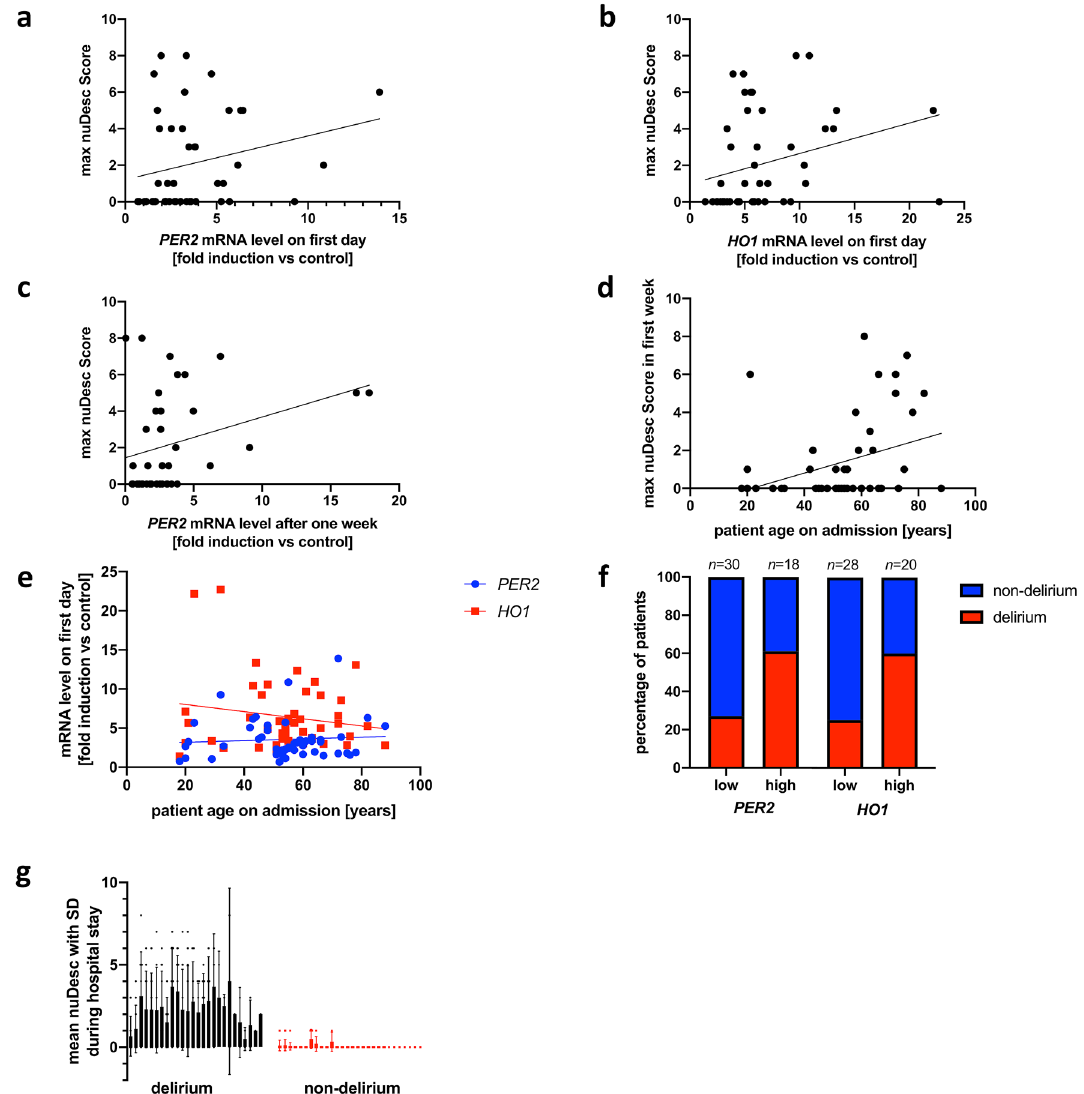
Figure 4. Correlation of PER2 and HO1 expression with delirium during hospitalization. (a–e) Linear regression curves between mRNA expression ( PER2/HO1 ) as well as patients’ age at admission and maximal nuDesc. (a,b) Correlation of PER2 (Spearman: r = 0.319, P = 0.027, Linear Regression: r 2 = 0.057, P = 0.104) and HO1 expression (r = 0.409, P = 0.004, r 2 = 0.075, P = 0.080) on first day of trauma with their maximal nuDesc during hospitalization. (c) Correlation of PER2 after 1 week and with their maximal nuDesc during hospitalization (r = 0.366, P = 0.024, r 2 = 0.083, P = 0.048). (d) Correlation of age at admission with the maximal nuDesc during the first week of hospitalization (r = 0.370, P = 0,010, r 2 = 0.105, P = 0.024). (e) ( Absent) Correlation between patients’ age at admission and PER2 (Spearman: P = 0.935, Linear Regression: P = 0.634) and HO1 expression ( P = 0.988, P = 0.247) on the first day of trauma. (f) Contingency diagrams analyzed via Fisher’s exact test showing distribution of delirium/non-delirium between patient groups of high and low mRNA expression levels of PER2 (Fisher’s exact test: P = 0.032, Koopman asymptotic score: RR = 2.92, 95% CI 1.15–4.64; Baptista-Pike: OR = 4.32, 95% CI 1.14–13.87) and HO1 ( P = 0.019, RR = 2.40, 95% CI 1.18–5.07; OR = 4.50, 95% CI 1.23–14.42). Categories of high and low expression levels of PER2 and HO1 were formed from linear regression of ISS and mRNA expression levels on first day of trauma (cf. Fig. 3a,b). (g) Higher individual dispersion of nuDesc during hospital stay in patients of the category “delirium” than “non-delirium” (Mann–Whitney-U test: P < 0.0001, cf. Methods/clinical assessment). nuDesc nursing delirium screening scale, 95% CI 95% confidence interval, OR odds ratio, PER2 period circadian regulator 2, HO1 heme oxygenase 1, ISS injury severity